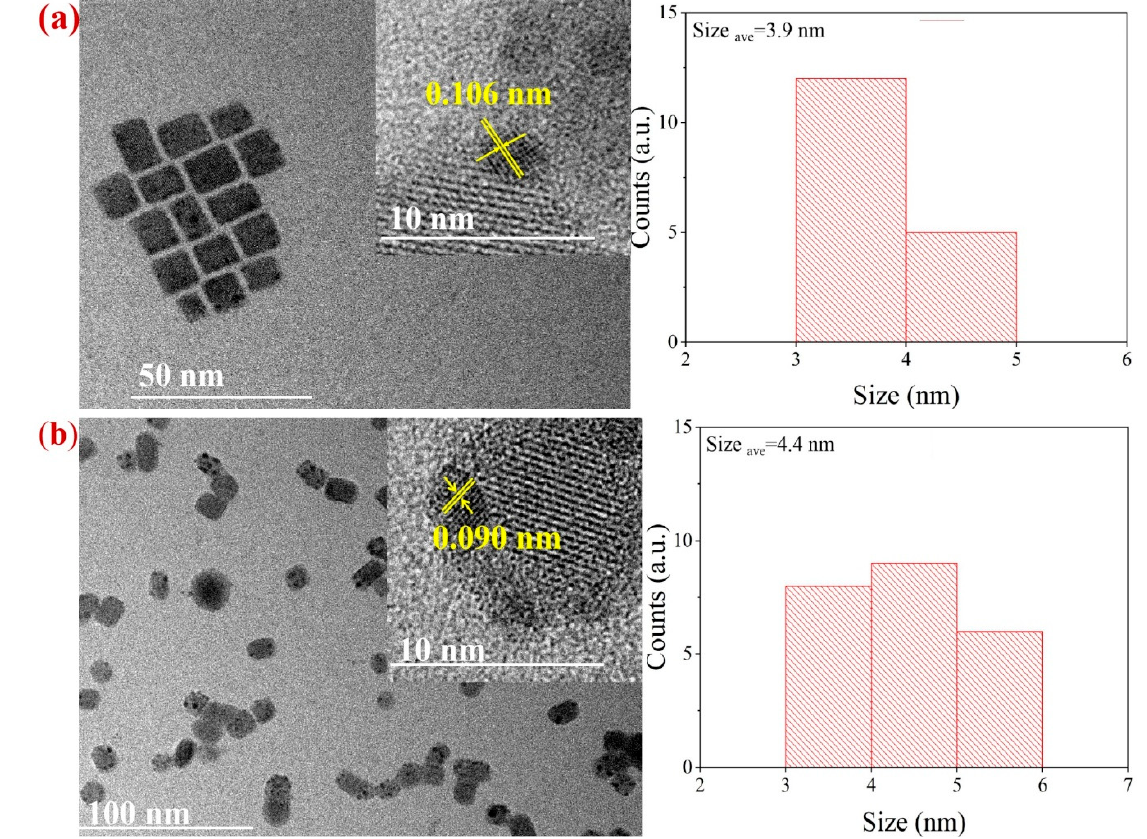
Figure 4. TEM images of ( a ) Au@CsPbBr 3 and ( b ) Pt@CsPbBr 3 NCs.